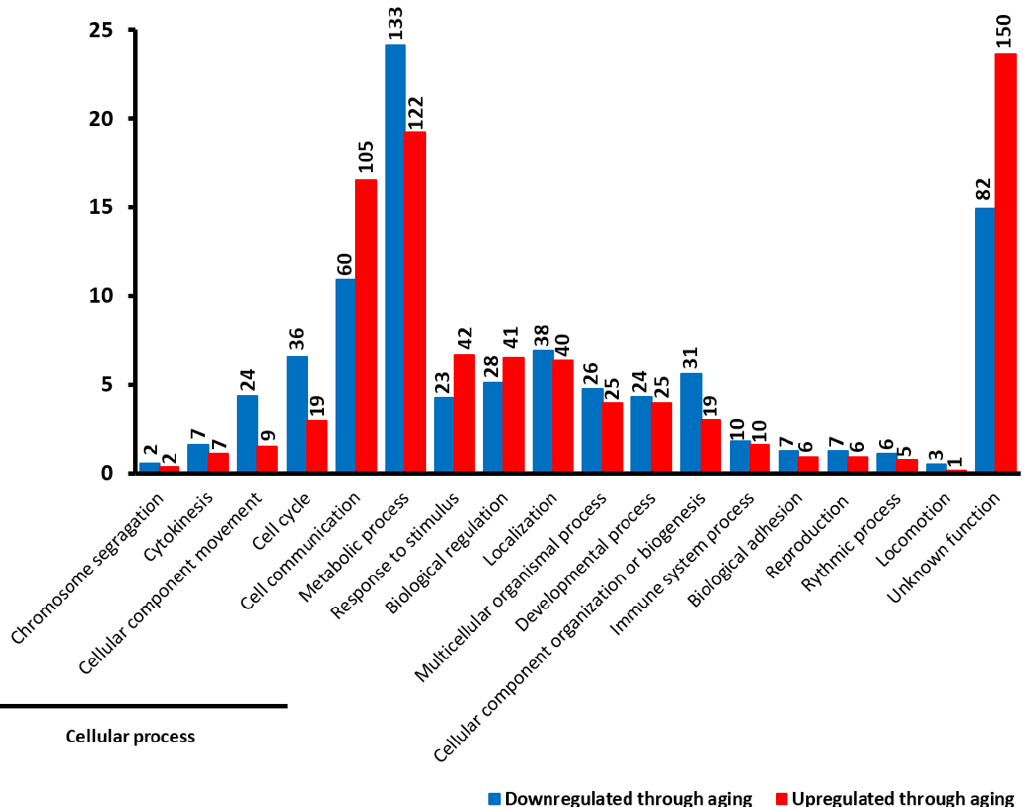
Figure 2. Overview of main cellular functions of 1184 differentially expressed genes between young and old age groups. The first five processes are subcategories of the “cellular process”. The height of each bar corresponds to the percentage of genes belonging to each specific process. Genes downregulated in the old age group are represented in blue, whereas genes upregulated in the old age group are represented in red. The black number at the top of each bar corresponds to the number of DEGs belonging to each specific process.